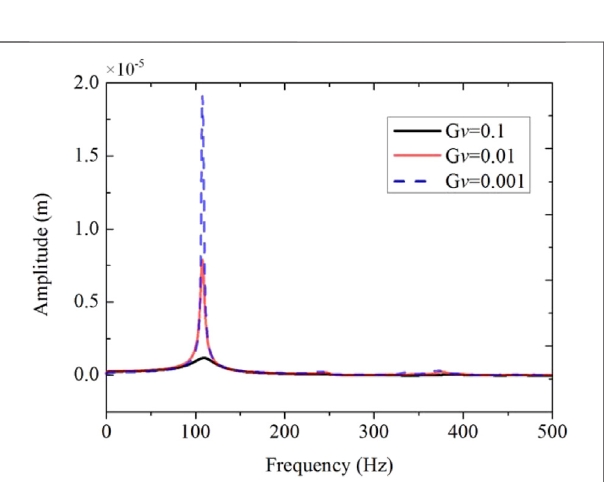
FIGURE 11 | Amplitude frequency response curve for the piezoelectric- integrated FG plate (CFCF).